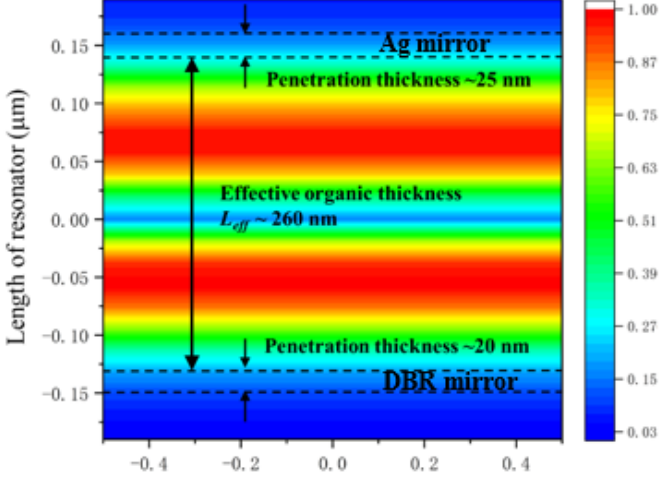
Figure 3. Field distribution of the wavelength 513 nm along the resonator.